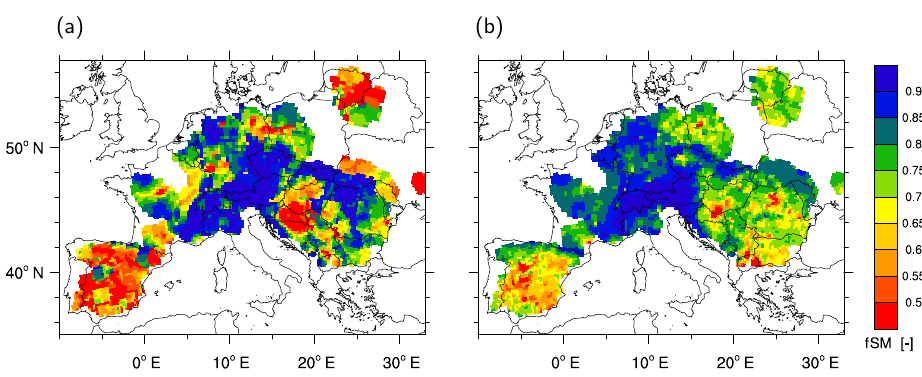
Figure 4. mHM simulations of soil moisture as the fraction from saturation θ parameter estimation and (b) seamless parameter estimation. Panel (b) shows a seamless soil moisture